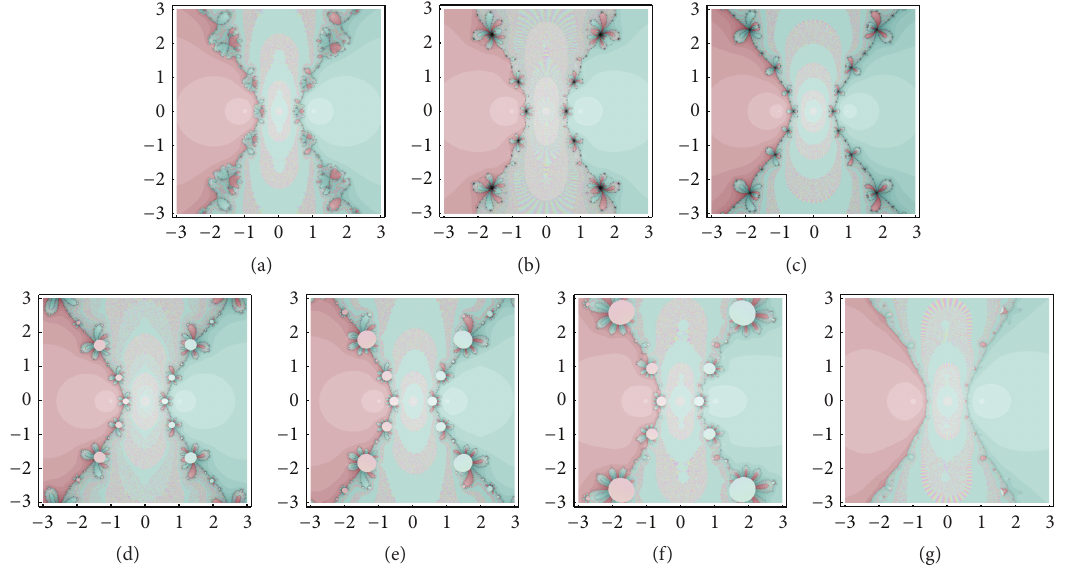
Figure 3: (a) for Kan , (b) for Sol , and (c) for Zhou and (d) for 1D , (e) for 1G , (f) for 2D , and (g) for 2G , for the roots of the polynomial (𝑧) = (𝑧 3 − 𝑧) 4 𝑃 3